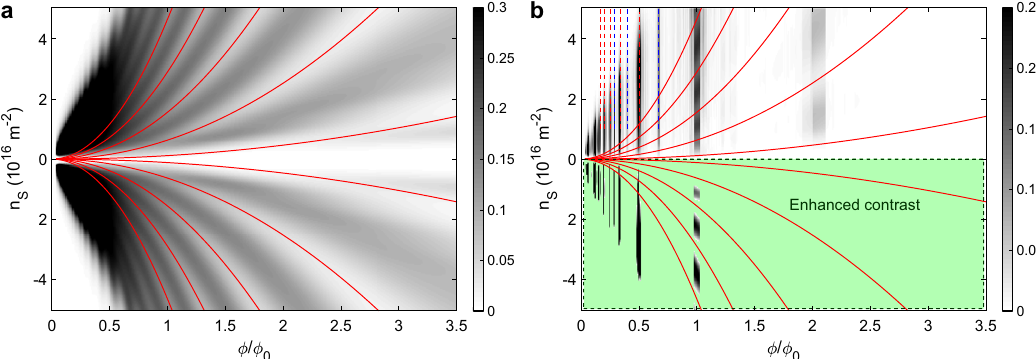
Fig. 5 Gray scale plots of the calculated conductivity contribution, in arbitrary units. a For a 1D superlattice, band conductivity oscillations appear, which depend on both the carrier density n S and fl ux quanta per unit cell ϕ / ϕ 0 . b In the case of a 2D superlattice, the band conductivity oscillations of the 1D case are mostly suppressed (light regions), except whenever the Hofstadter butter fl y has extended regions (dark bands), at rational fractions of ϕ / ϕ 0 . The features in the experimental data are reproduced, including the appearance of band conductivity maxima at rational fractions of ϕ / ϕ 0 and the modulation of the observed Brown – Zak oscillations by Weiss oscillations (lower part: enhanced contrast). The red continuous lines in both fi gures show the semi- classical fl at band condition (see Eq. 2). Dashed lines mark rational ϕ / ϕ 0 < 1, red for unit fractions, blue other. Note that the two triangular regions at low ϕ / ϕ ∣ n ∣ do not contain meaningful data due to a limited number of Landau levels in the 0 and high S